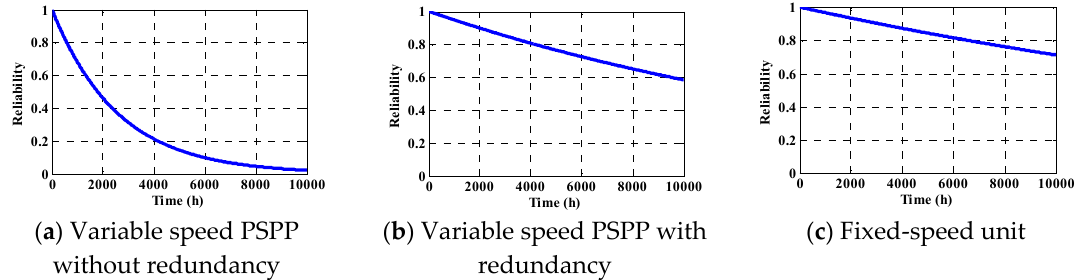
Figure 7. Reliability of a 250-MW pumped-storage power plant unit.